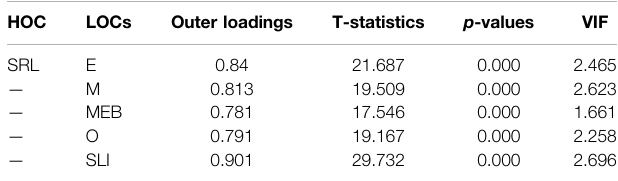
TABLE 5 | Hierarchical order